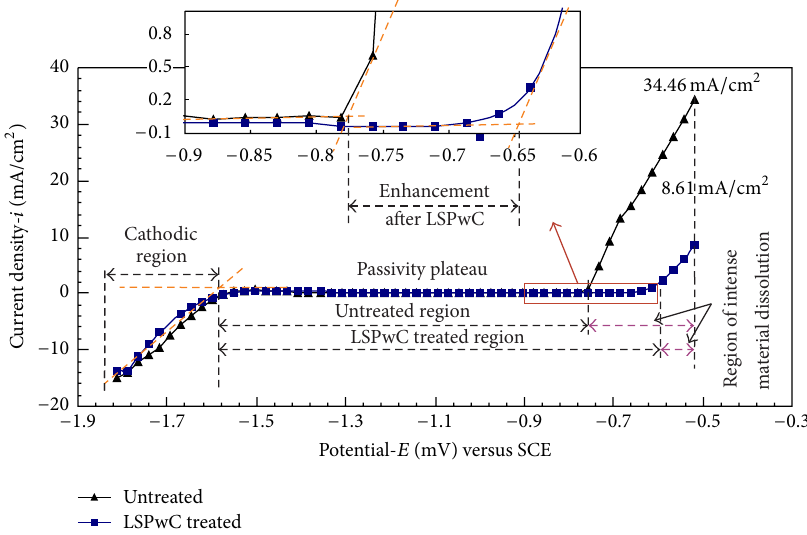
Figure 7: Linear voltammograms of the untreated and LSPwC treated